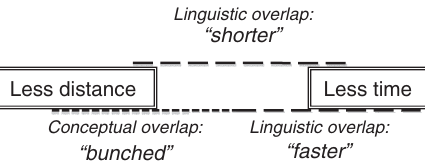
FIG. 2. Connections among intuitive knowledge elements in the ticker tape scenario. Long dashes signify linguistic overlap; short dashes signify conceptual